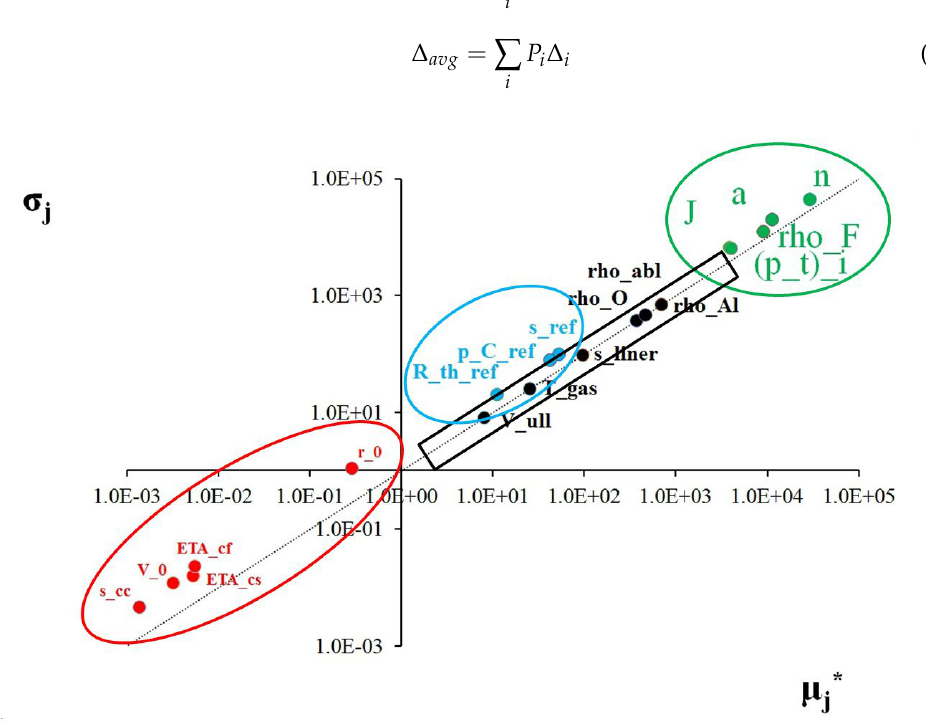
Figure A3. SA outputs: σ j vs. µ ∗